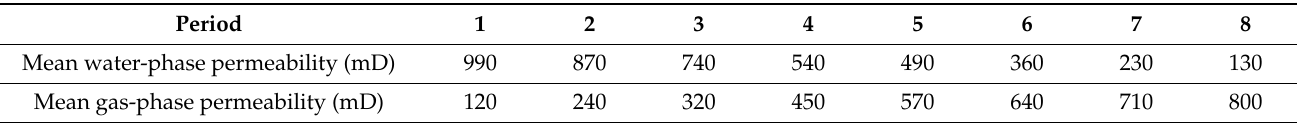
Table 3. Permeability values for the calculation of the two-dimensional